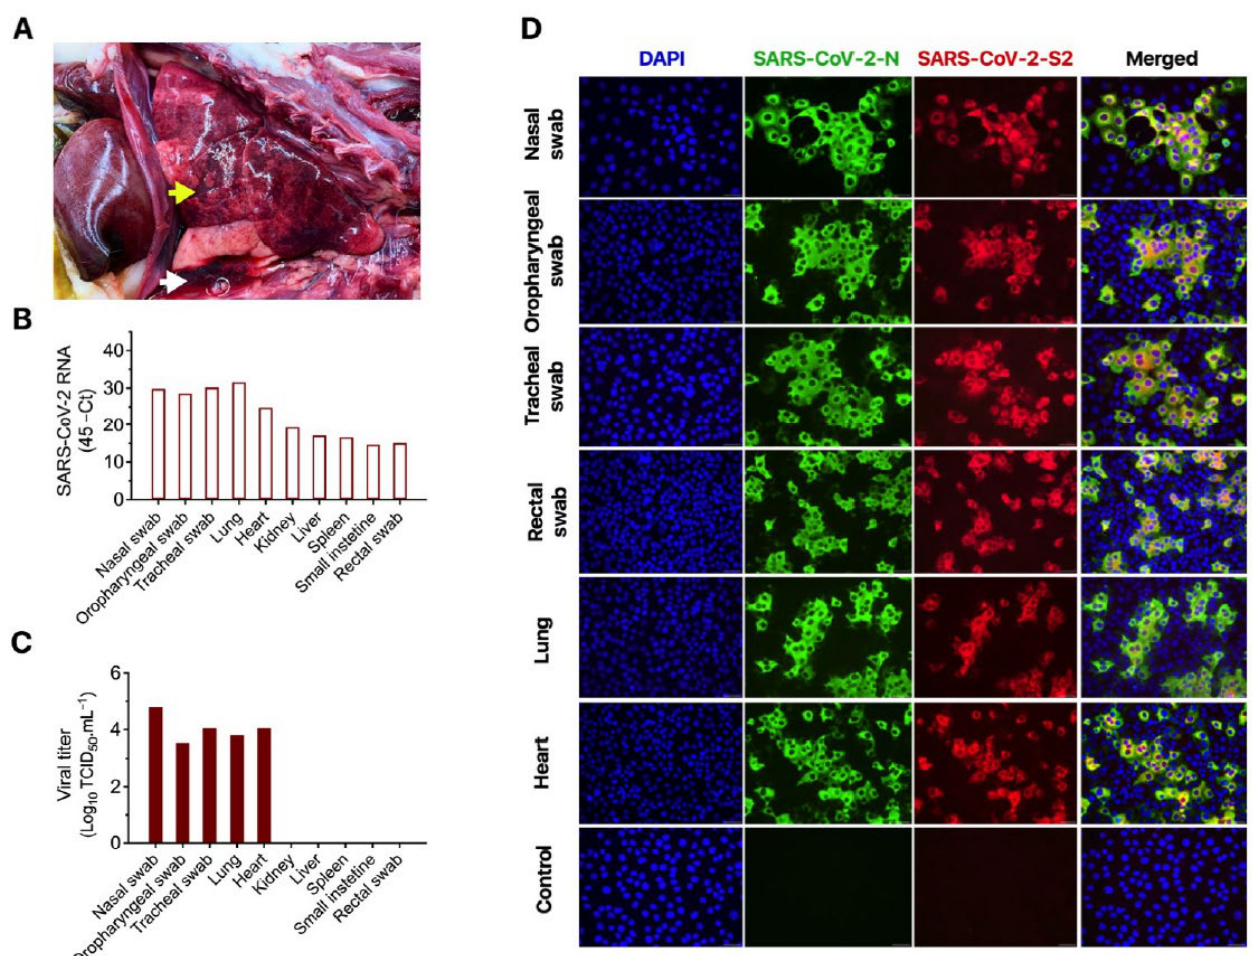
Figure 1. Gross pathological and virological findings in a domestic cat presenting progressive respiratory disease. ( A ) Lungs are mottled red with focal depressed areas in the parenchyma (yellow arrow). A red tinged fluid is present in the thoracic cavity (white arrow). ( B ) Viral RNA detected in respiratory secretions, feces and in lung, heart, kidney, spleen and intestine as determined by real-time RT-PCR. ( C ) Viral titers in respiratory secretions, in lung and heart as determined using end-point titrations and the Spearman and Karber’s method and expressed as TCID 50 .mL − 1 . ( D ) Virus isolation was confirmed by immunofluorescence. For this, Vero-E6/TMPRSS2 cells were inoculated with cell lysate of virus isolation assays performed in respiratory secretions, feces, lung and heart tissue homogenates. At 24 h post-inoculation cells were fixed and subjected to IFA using a polyclonal antibody anti-SARS-CoV-2-nucleoprotein (N) (green), a mAb anti-SARS-CoV-2-Spike protein S2 subunit (red) and the nuclear counterstain performed with DAPI (blue). This confirmed isolation of SARS-CoV-2 from nasal secretions, oropharyngeal and tracheal secretions, feces and from the lungs and heart of the cat. 40X magnification.